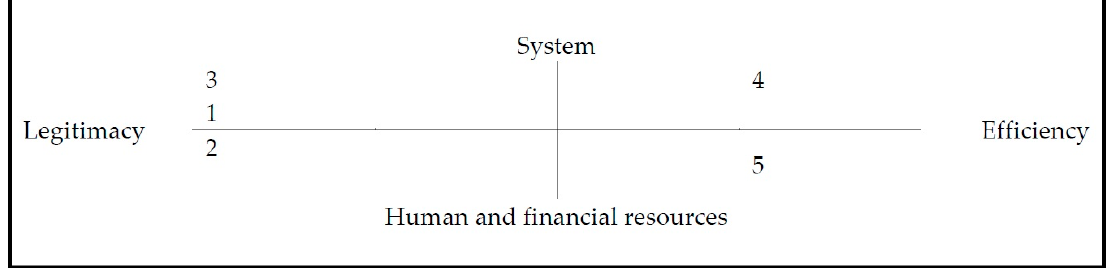
Figure 4. Secondary Aspects.